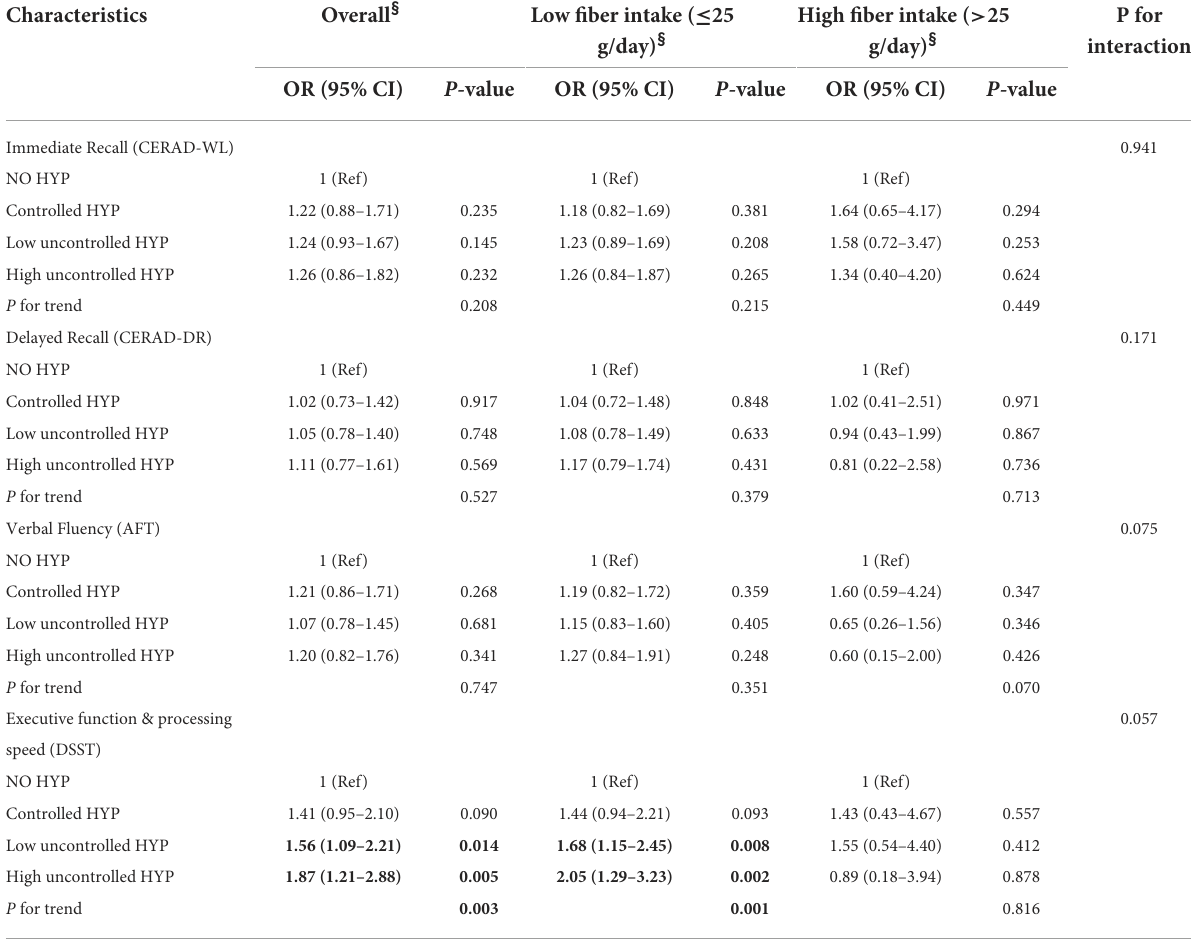
TABLE 4 HYP status and cognitive function impairment by levels of fiber intake among participants aged 60 years and older from the National Health and Nutrition Examination Survey (NHANES) (2011–2014).